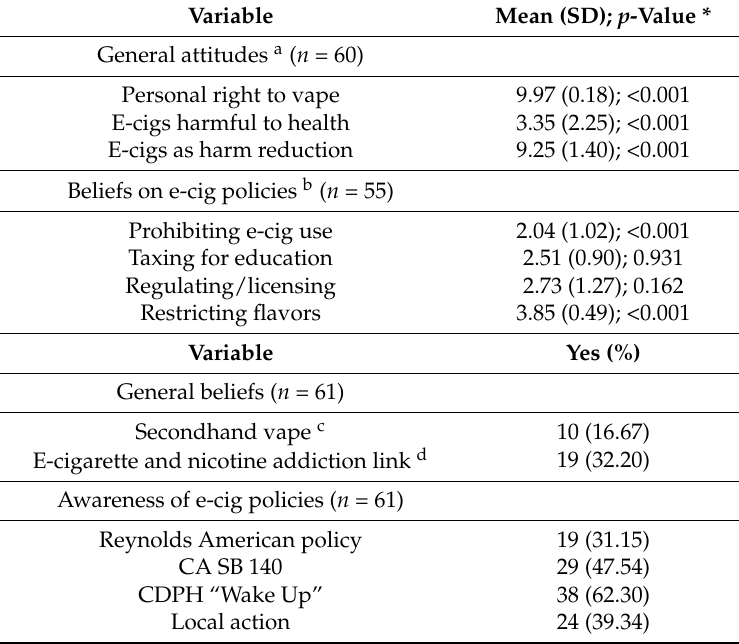
Table 4. Vape shop employees ( n = 61) from Year 2 only: general attitudes and beliefs of e-cigarettes and policies; awareness of e-cigarette/pro-vape groups; information sources of these groups; and other related